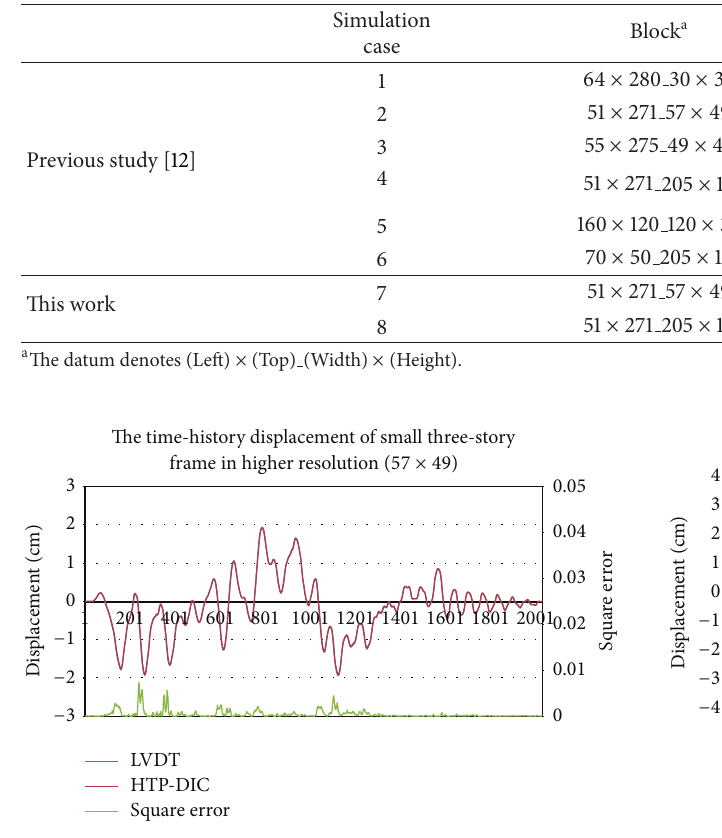
Figure 13: Time history of displacement and square error of displacement of small three-story frame at low resolution (10 ×